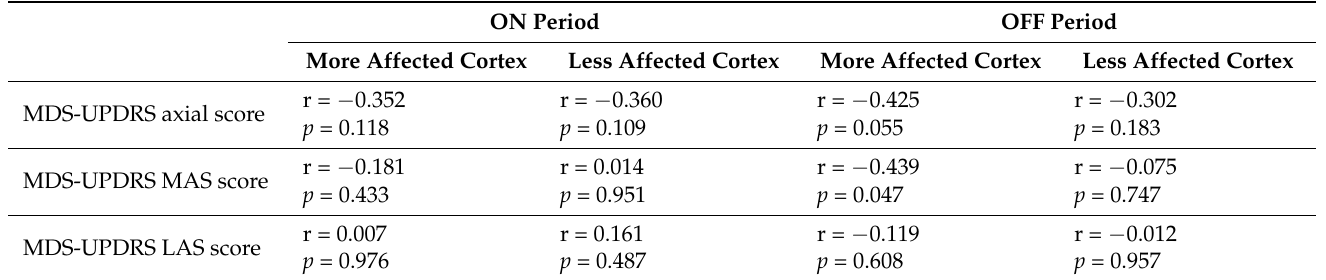
Table 2. Correlation between the resting motor thresholds and the motor subscore in the ON and OFF periods. ON Period OFF Period More Affected Cortex Less Affected Cortex More Affected Cortex Less Affected